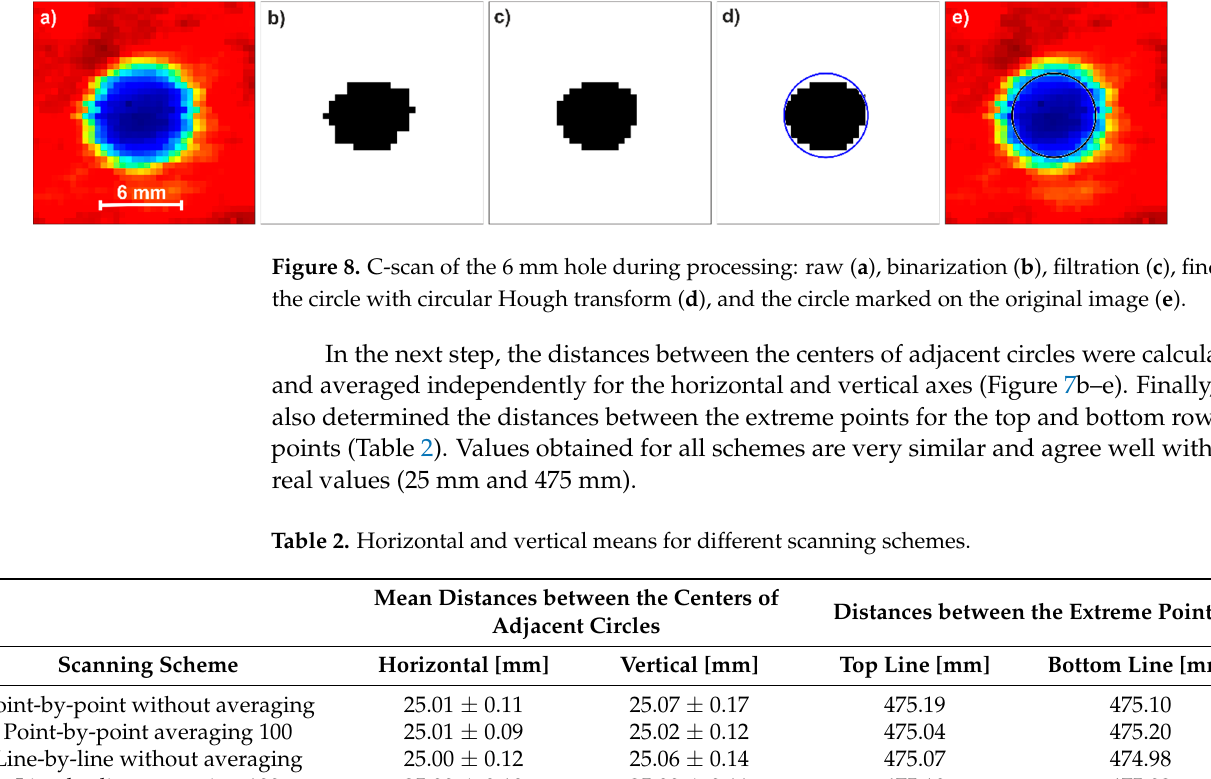
Figure 7. The C-scan of the breadboard for point-by-point without averaging scheme ( a ) and C- scans of first four spots for following schemes: point-by-point without averaging ( b ), point-by-point averaging 100 ( c ), line-by-line without averaging ( d ), and line-by-line averaging 100 ( e ). To compare the C-scans, we quantified the uniformity of spot distribution. For each spot, we determined a circle with a diameter of 6 mm, whose center was calculated by the